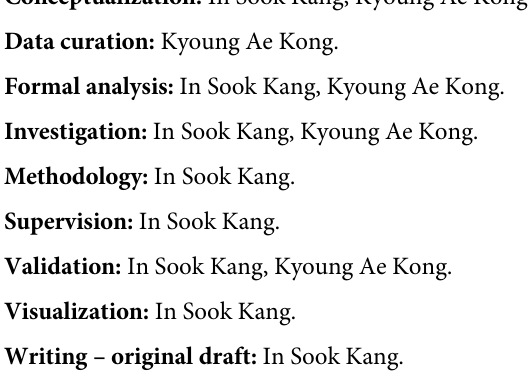
S1 Fig. Number of critical and fatal illnesses, and fatalities according to body mass index. The left y-axis presents bar graphs showing the number of critical and fatal illnesses, and the right y-axis presents as a line graph showing fatality.